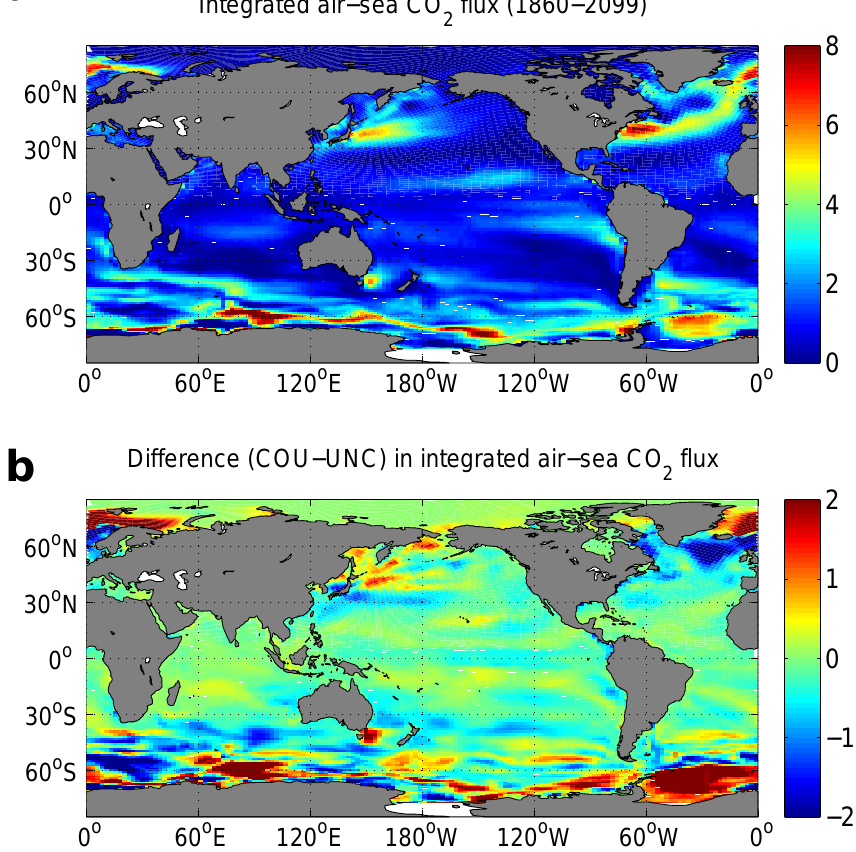
Fig. 8. Map of (top) time-integrated (1860–2099) changes in carbon uptake relative to the pre-industrial period (1850–1859) from the COU simulations and (bottom) the difference between the fully coupled and the uncoupled simulations (COU-UNC). Units are in [kgC/m 2 ]